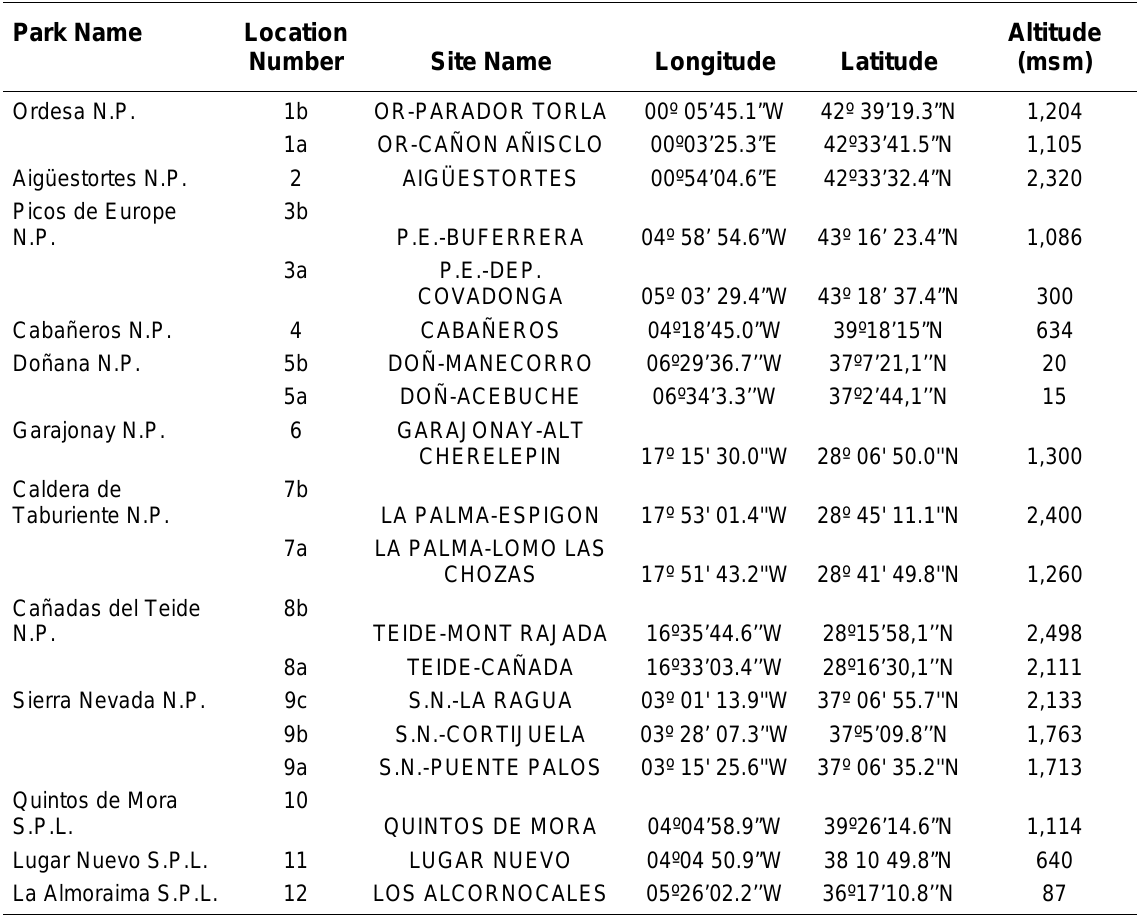
Coordinates and Altitude of the Different Sampling